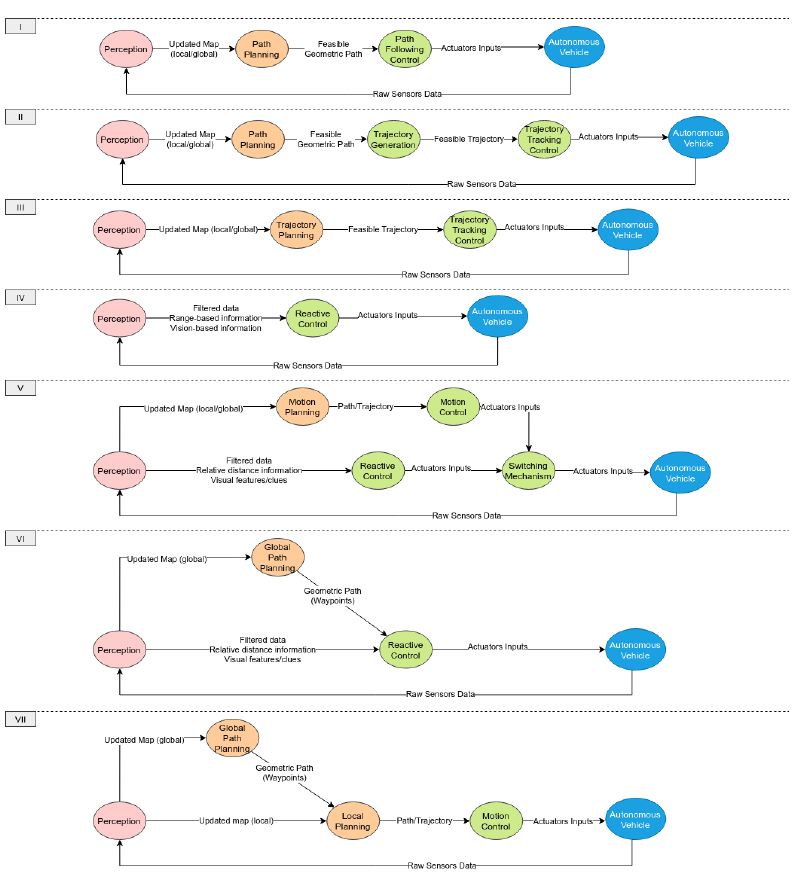
Figure 7. Different autonomous navigation control